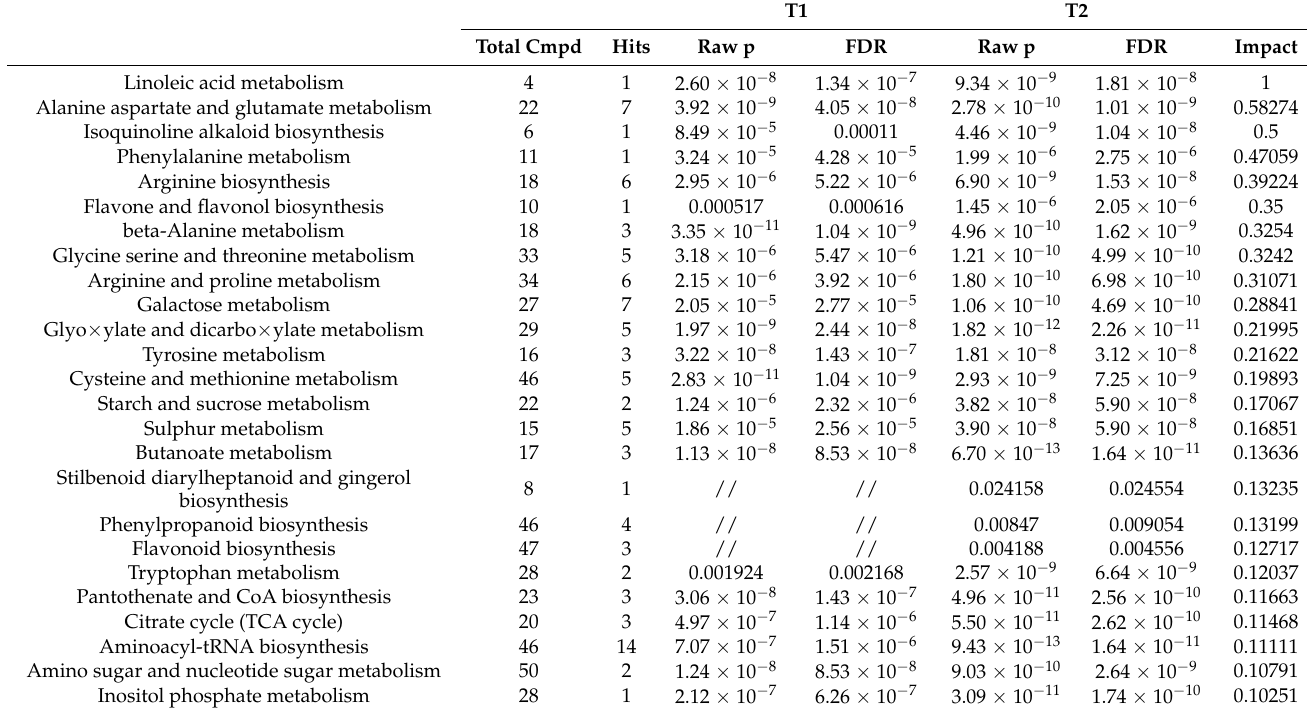
during seed germination, were significantly impacted by coumarin treatment (Table 2). Table 2. Result from “Pathway Analysis” (topology + enrichment analysis) carried out on the metabolite identified in R. sativus seeds during the germination process (T0–T2) in response to different coumarin doses (0 µ M and 400 µ M). T1 T2 Total Cmpd Hits Raw